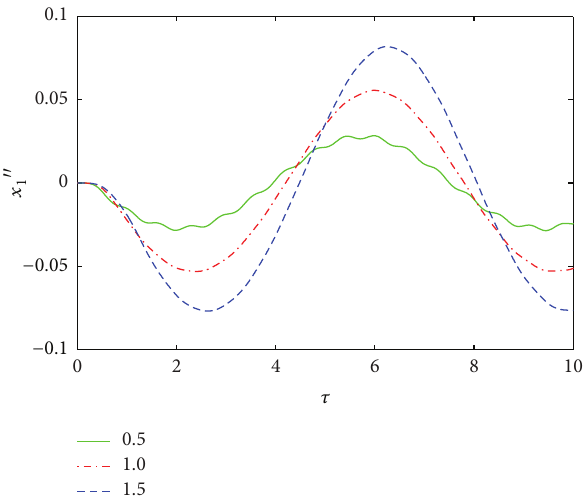
Figure 4: The effect of the dimensionless pulse duration on dimensionless acceleration response of critical components, where = 0.1 , 𝜑 = 60 ∘ , 𝜆 = 10 , and 𝜆 = 0.01 . 𝛽 ̈𝑢 0𝑚 0 1 2